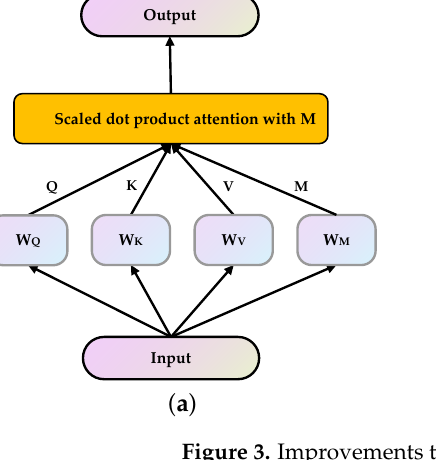
Figure 3. Improvements to the attention mechanism. ( a ) Improvement of self-attention mechanism in each encoder sublayer. ( b ) The structure of